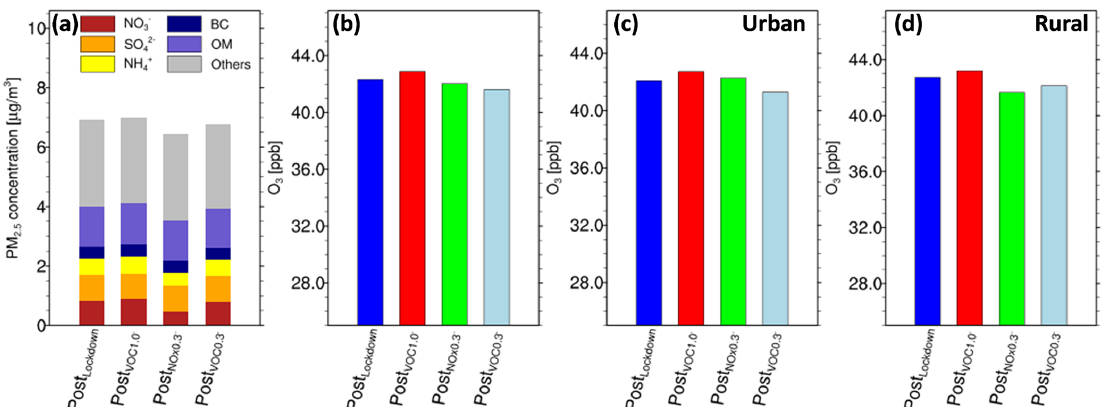
Figure 8. Simulated population-weighted PM 2 . 5 and O 3 concentrations under three sensitivity scenarios (VOC1.0, NO x 0.3, and VOC0.3) during the lockdown period (19 March to 23 April) over southern California. (a) PM 2 . 5 components, (b) MDA8 O 3 , and (c) MDA8 O 3 over the urban areas, as well as (d) MDA8 O 3 over the rural areas. The definitions of all scenarios are summarized in Table 1.